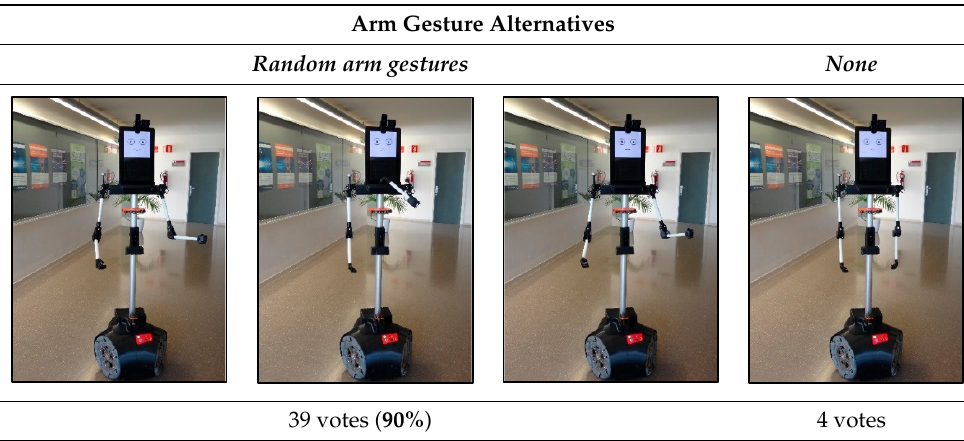
Table 10. Alternatives considered to implement the arm gestures and votes received.